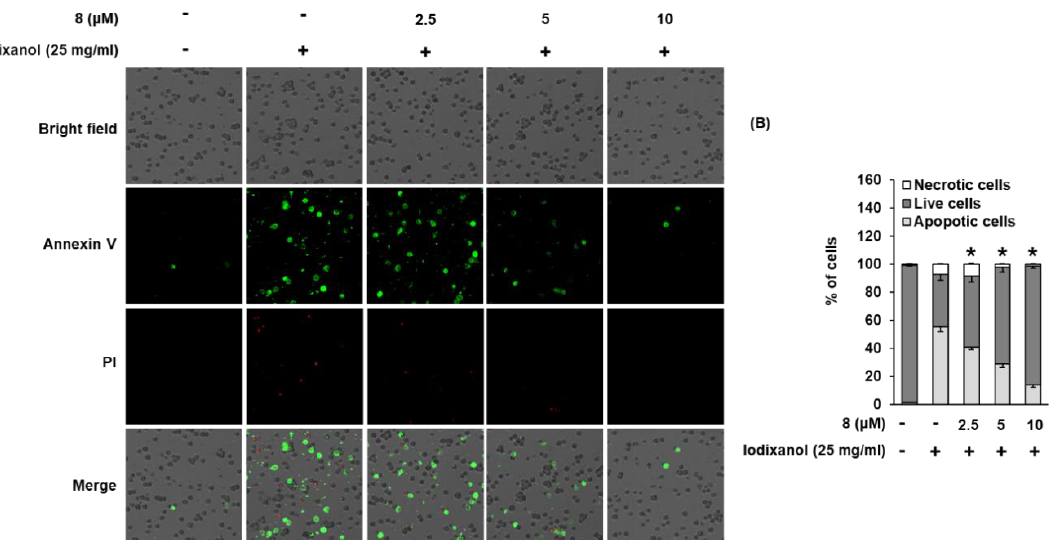
Figure 7. Effect of 3- epi- iso -seco -tanapartholide (compound 8 ) isolated from Artemisia argyi on iodixanol-induced Figure 7. E ff ect of 3- epi -iso- seco -tanapartholide (compound 8 ) isolated from Artemisia argyi on apoptosis in LLC-PK1 cells. ( A ) Cells were treated to 25 mg/mL of iodixanol in the presence or absence of iodixanol-induced apoptosis in LLC-PK1 cells. ( A ) Cells were treated to 25 mg / mL of iodixanol compound 8 for 24 h, and stained with annexin V Alexa Fluor 488 (green fluorescence) and PI (red fluorescence). in the presence or absence of compound 8 for 24 h, and stained with annexin V Alexa Fluor 488 Images were quantitatively determined using a Tali image-based cytometer. ( B ) The percentages of apoptotic, (green fluorescence) and PI (red fluorescence). Images were quantitatively determined using a Tali necrotic, and live cells are represented as a bar graph (mean  SD, n = 3, * p < 0.05 compared with iodixanol- image-based cytometer. ( B ) The percentages of apoptotic, necrotic, and live cells are represented as a treated LLC-PK1 cells). bar graph (mean ± SD, n = 3, * p < 0.05 compared with iodixanol-treated LLC-PK1